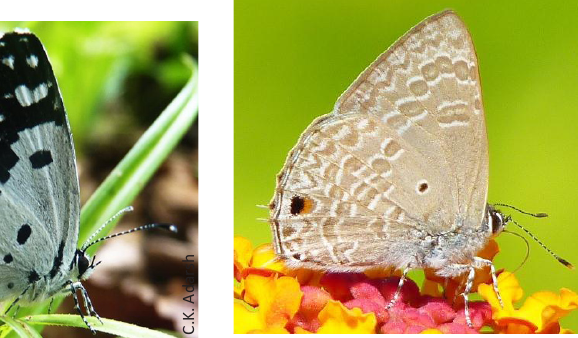
Image 73. Lampides boeticus Pea Blue